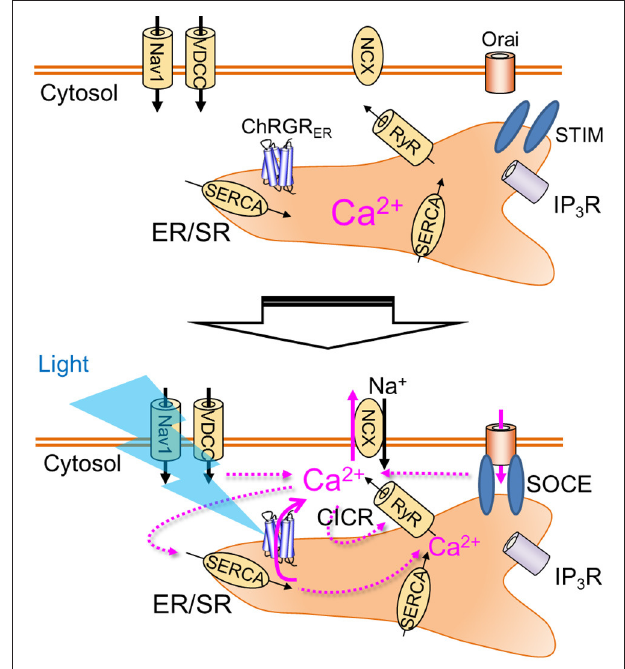
FIGURE 6 | Organelle optogenetics. In the present study, the endoplasmic reticulum/sarcoplasmic reticulum (ER/SR)-targeted channelrhodopsin, ChRGR ER was selectively expressed in the ER/SR membrane. The light absorption by this molecule triggers release of Ca 2 + from the intracellular store, which activates various Ca 2 + signaling cascades such as calcium-induced calcium release (CICR) or store-operated calcium entry (SOCE). Nav1, voltage-dependent sodium channel 1; VDCC, voltage-dependent calcium channel; NCX, Na + -Ca 2 + exchanger; RyR, ryanodine receptor; IP 3 R, IP 3 receptor; SERCA, sarco/endoplasmic reticulum Ca 2 +